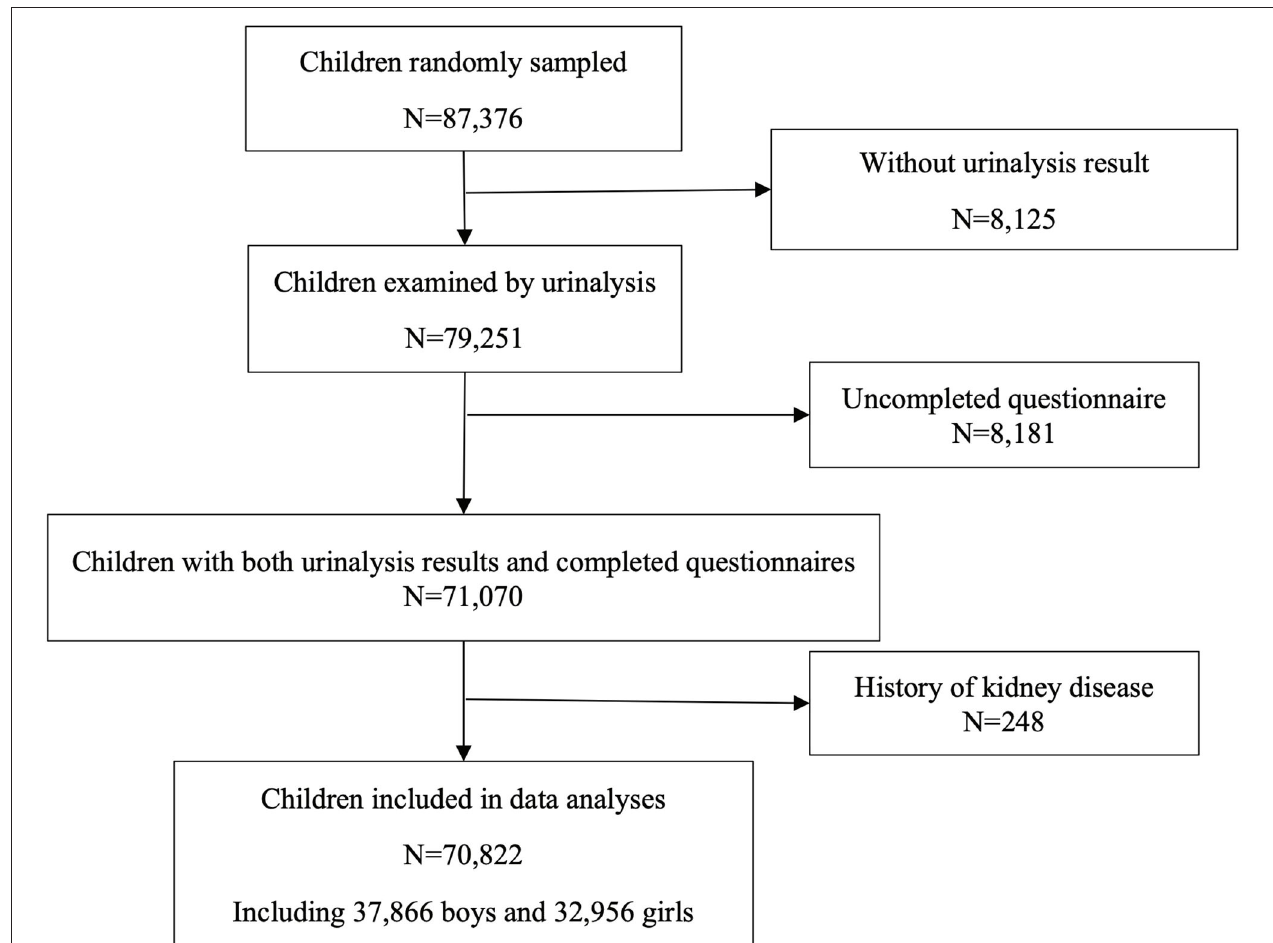
FIGURE 1 | Flow diagram of children